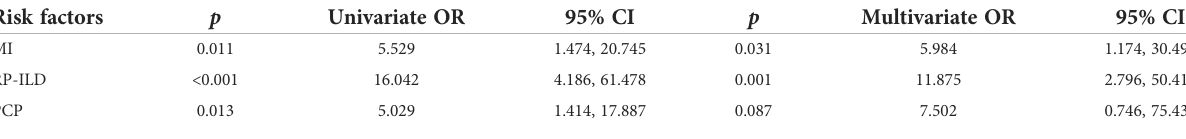
TABLE 6 Logistic regression analysis of associated factors for the death of anti-MDA5 Ab+ DM/CADM patients. Risk